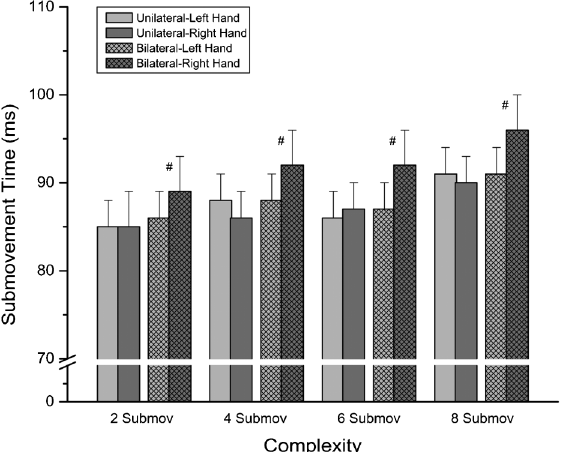
Figure 3. Left hand and right hand submovement times in milliseconds for the unilateral and bilateral responses for the four complexity levels. Data are reported as means±SE for 16 participants. Submov: submovements. # P , 0.05 comparing left and right hands (repeated measures analysis of variance followed by the Tukey test).